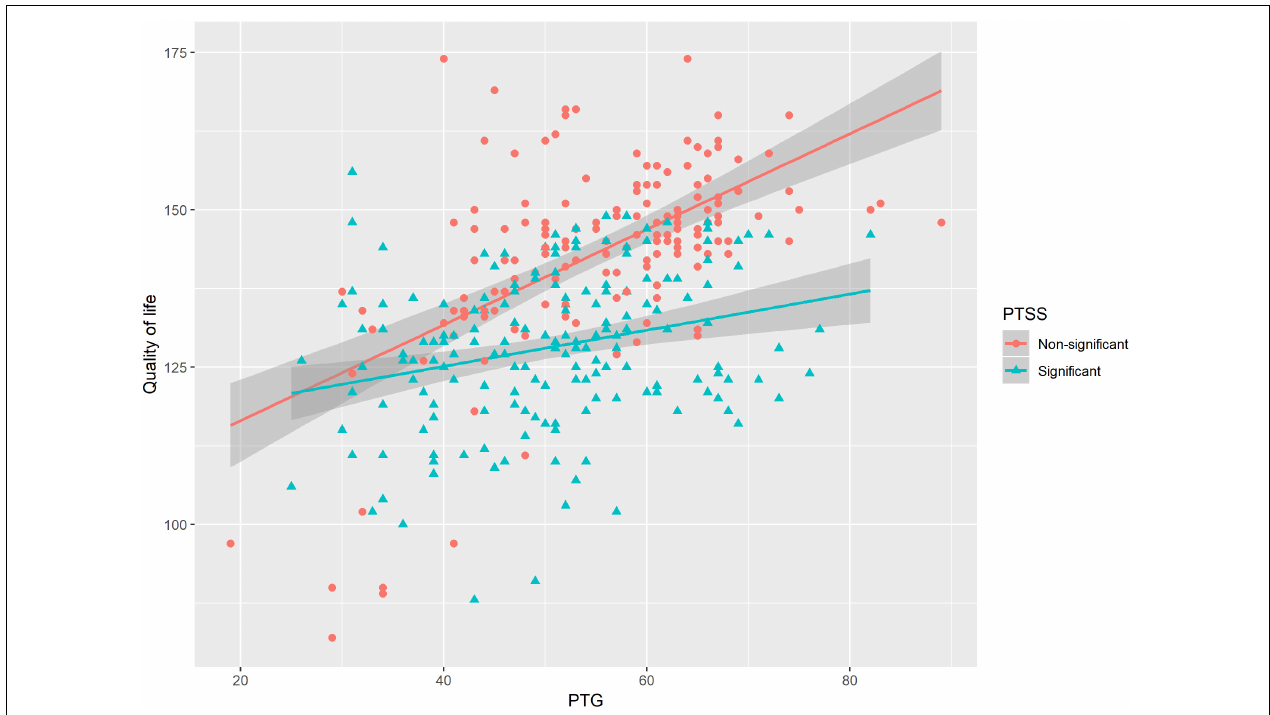
FIGURE 3 | The moderating effect of PTSS on the relationship between posttraumatic growth (PTG) and